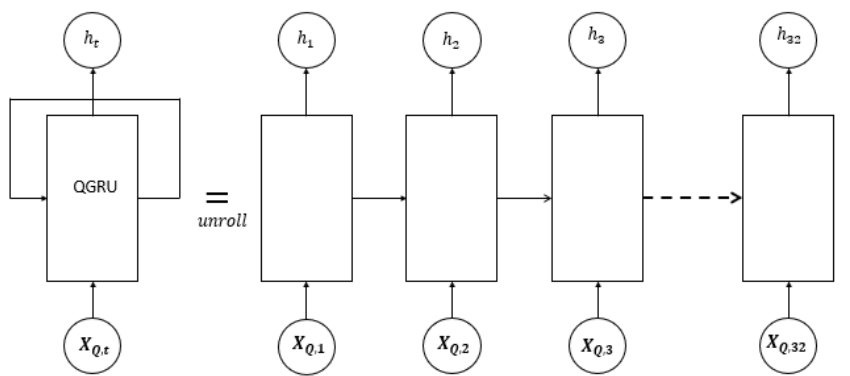
Figure 4. Unrolled QGRU architecture for the Human Activity Recognition (HAR) task.